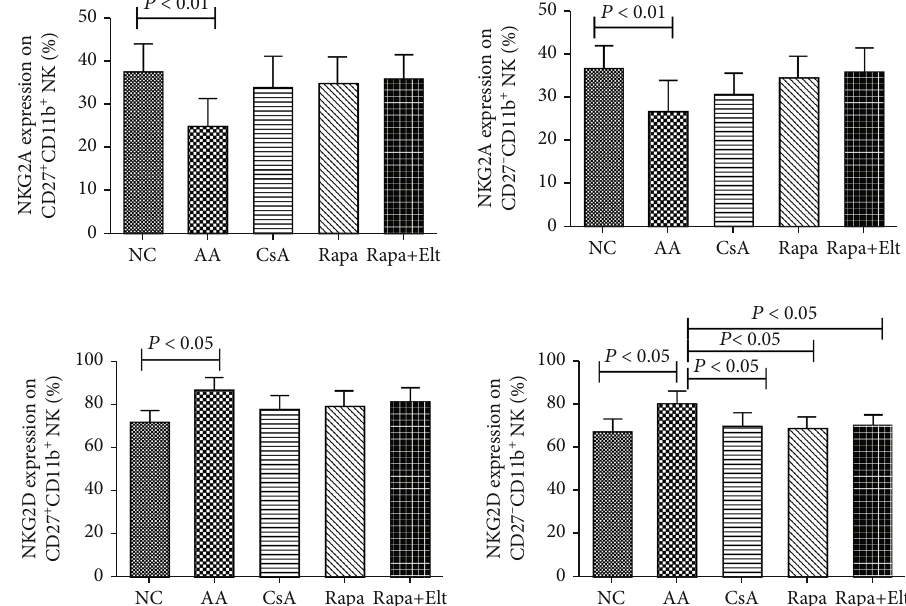
Figure 4: E ffi cacy of rapamycin combined with eltrombopag on NK functional molecules. The expression of NKG2A was signi fi cantly downregulated and NKG2D upregulated in the AA group compared with the NC group ( P < 0 : 05 ). The expression of NKG2A on peripheral regulatory and functional NK cells was upregulated in the CsA group, Rapa group, and Rapa+Elt group ( P > 0 : 05 ). The expression of NKG2D on the peripheral regulatory and functional NK cells was downregulated in the CsA, Rapa, and Rapa+Elt groups compared with the AA group, but there is statistical signi fi cance only for functional NK cells ( P < 0 : 05 ). Moreover, there is no notable di ff erence in the NKG2A and NKG2D expression between the Rapa group and Rapa+Elt group. There was no signi fi cant di ff erence between the e ff ect of Rapa and CsA on the function of NK cells.